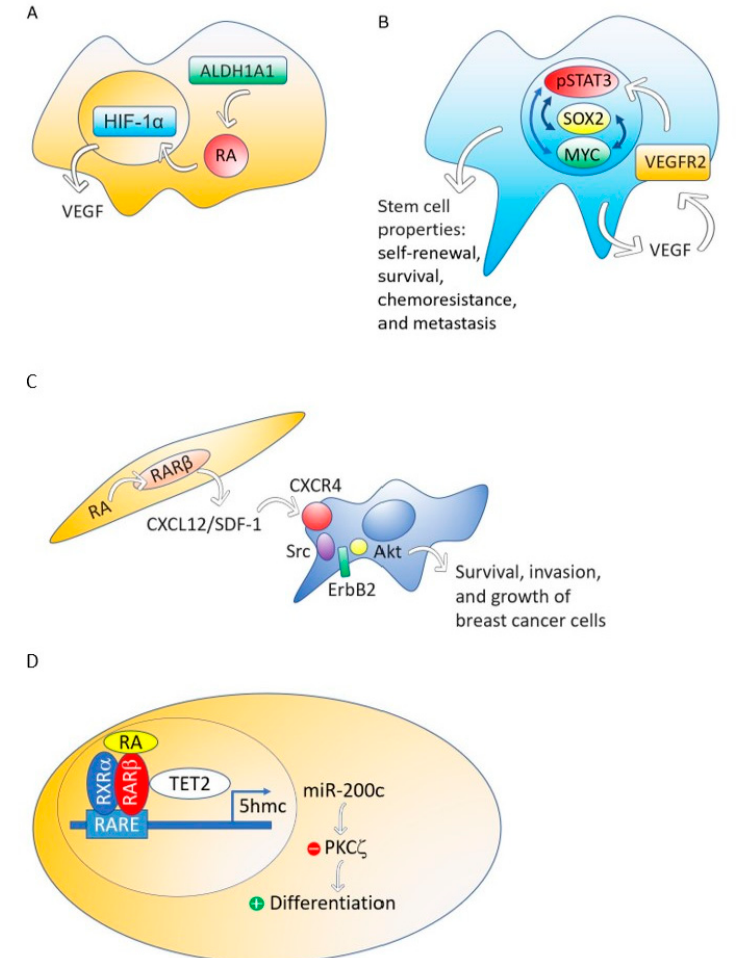
Figure 2. The ALDH1A1-retinoic acid-HIF-1 α -VEGF pathway is activated in breast cancer MCF-7 cells ( A ). VEGF drives breast and lung cancer-initiating stem cells through the